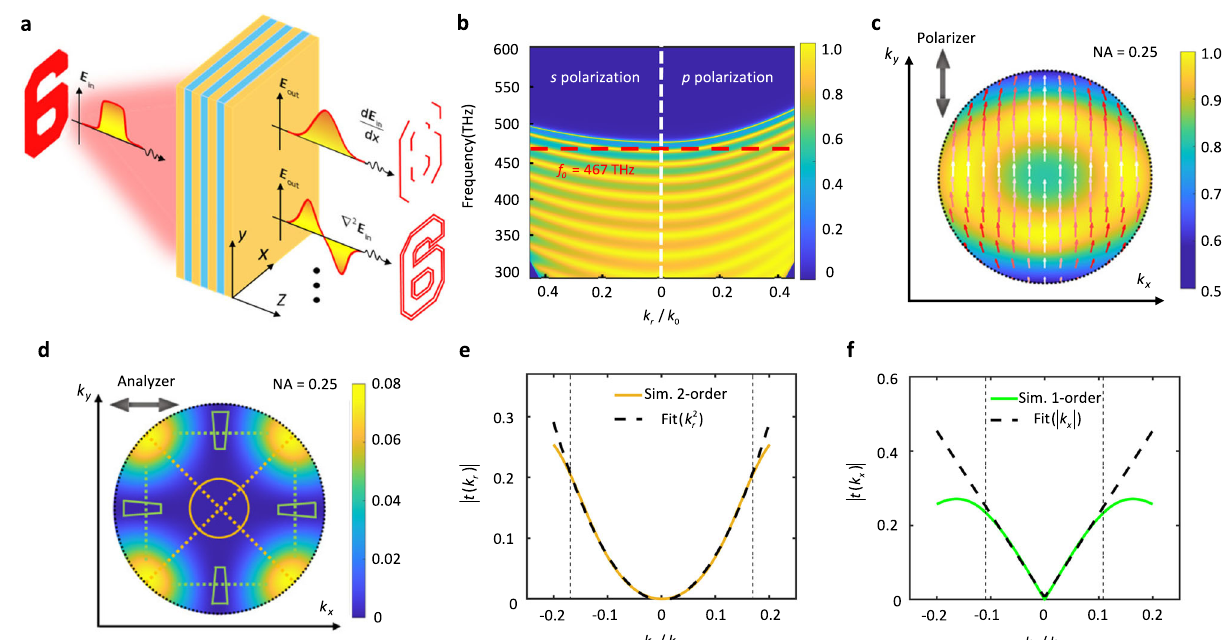
Fig.1|Planarphotonicchipforspatialdifferentiation.a Schematicofaphotonic chipactingasaspatialdifferentiatorthattransformsanimageintoits fi rst-,second- and even higher order derivative. The chip ismade from a well-designed dielectric multilayer structure. b Simulated color-coded transmission coef fi cient amplitude asa function of frequencyand in-plane wavenumber for the s- and p -polarizations. c SimulatedtransmissionBFPimagethroughthedielectricmultilayeratanincident wavelength of 643nm. The double arrow-headed black line at the top left corner indicates the polarization orientation of the incident light. The colored one-way arrows indicate the polarization direction of transmitted light in the momentum space, the polarization de fl ection increases as the color change from white to red. d Simulated transmissionBFP image when an analyzer is placed after the dielectric multilayer. The polarization orientation of the analyzer lies perpendicular to the